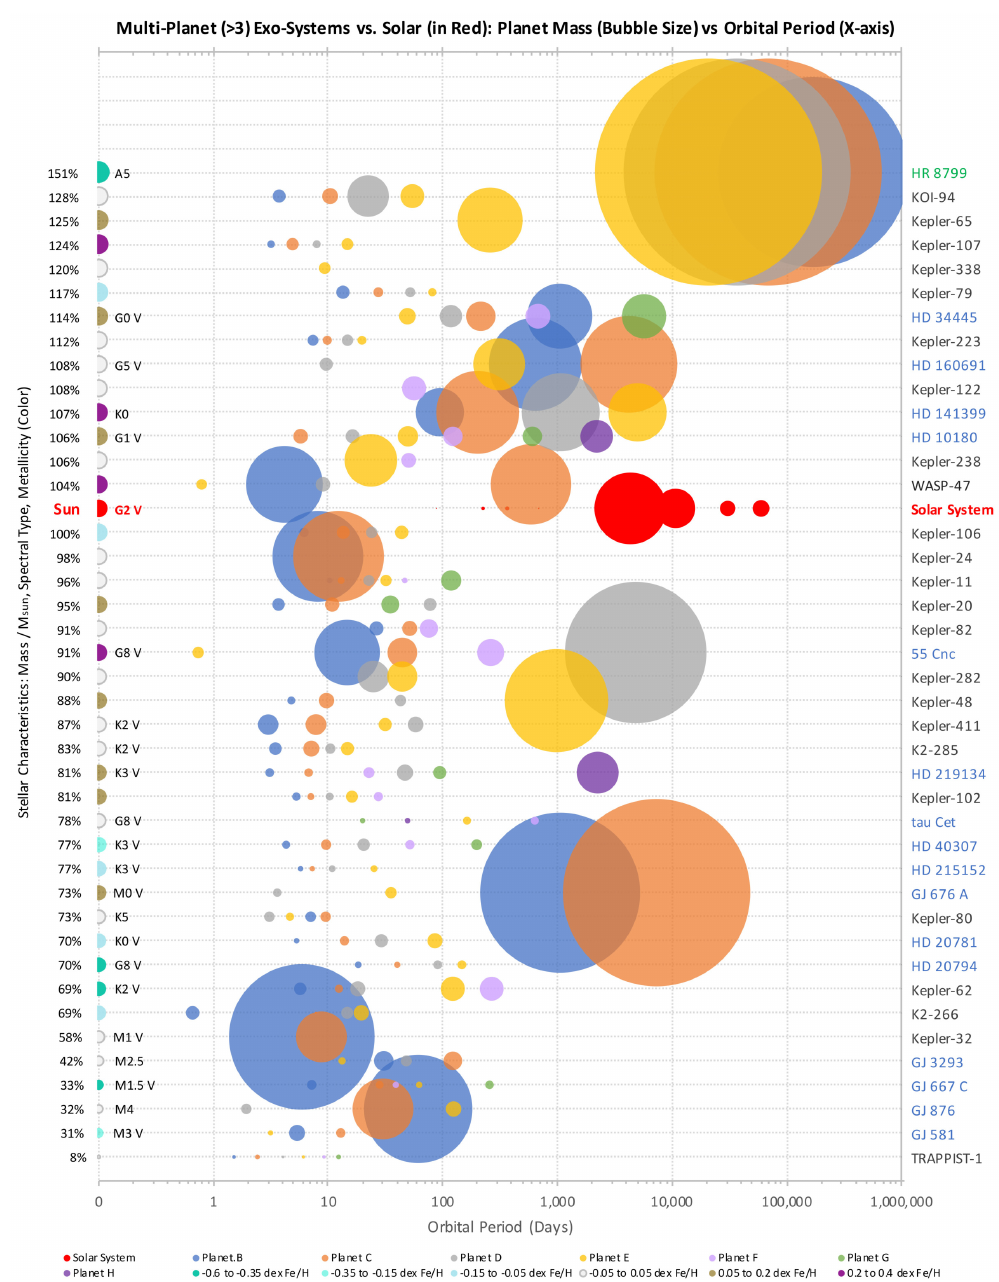
Figure 23. Exoplanetary systems with more than three planets (for which planets’ masses and orbital periods are available in NASA Exoplanet Archive [267] as of 28 November 2019). Planet masses are to scale relative to one another. Planet colors represent their discovery order (in accordance with exoplanet naming convention). For comparison, Mercury, Venus, Earth, Mars, Jupiter, Saturn, Uranus, and Neptune, are also depicted, in bright red. Planetary systems are labeled on the right: green label indicates detection by imaging; blue—by radial velocity; black—by transit (with exception of planets Kepler-20g and WASP-47c detected by radial velocity; and Kepler-82f, Kepler-122f, and Kepler-411e, detected by transit timing variations). Stellar characteristics noted on the left vertical axis are: M star as percent of the Sun, spectral type (when available), and Fe/H metallicity (colored by dex ranges: − 0.60 to − 0.35; − 0.35 to − 0.15; − 0.15 to − 0.05; − 0.05 to +0.05; +0.05 to +0.20 ; and +0.20 to +0.40). Sizes of stellar bubbles (representing M star ) are relative to each other (not to